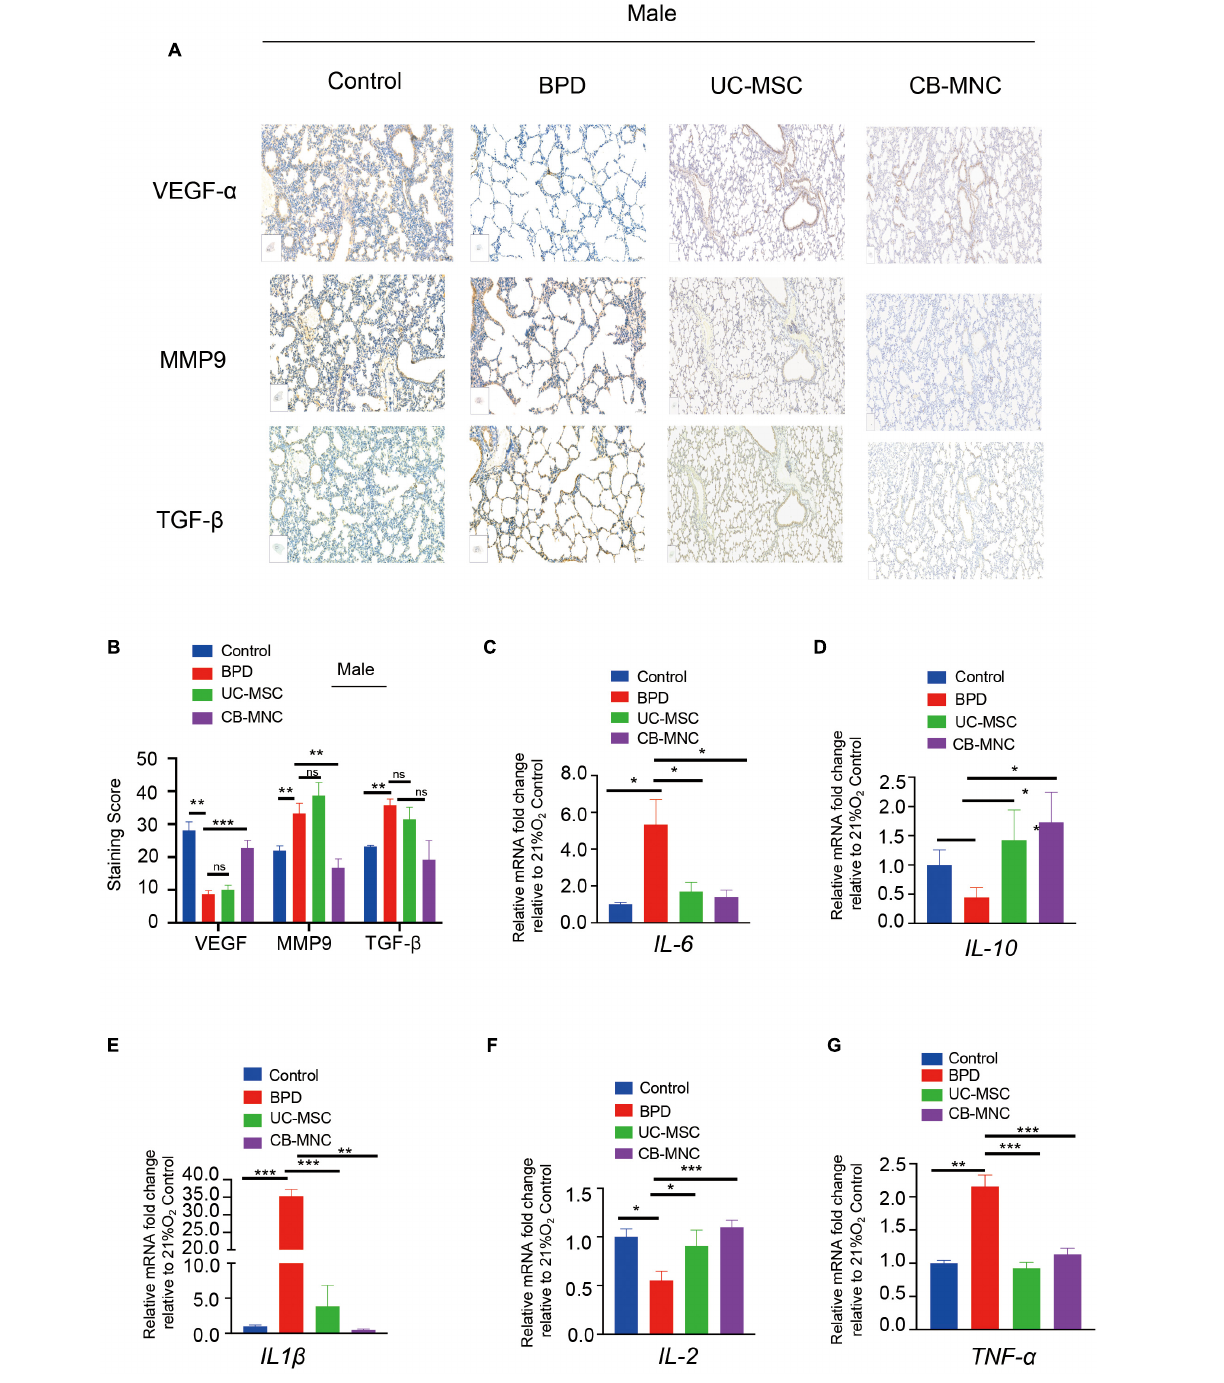
FIGURE 4 | Expression profiles of inflammatory factors and in lung of UC-MSC- and CB-MNC-infused mice. (A) Immunohistochemical staining of vascular endothelial growth factor (VEGF), transforming growth factor- β 1 (TGF- β 1), and matrix metalloproteinase-9 (MMP-9) in lung tissue of male mice. Positive staining of cytoplasm is yellow-brown and that of nuclei is blue. Scale bar: 100 µ m. (B) Summary of the quantification of the immunohistochemical staining of the indicated factors in (A) . (C–G) Lung tissue was collected from mice in each group at postnatal day (PN)28. Transcriptional levels of cytokines and growth factors were determined by quantitative reverse transcription polymerase chain reaction analysis. (C) Interleukin (IL)-6, (D) IL-10, (E) IL1- β , (F) IL-2, (G) tumor necrosis factor (TNF)- α . p-values are based on two-sided Mann–Whitney U -tests. *p < 0.05, **p < 0.01, ***p < 0.001. Data are representative of three independent biological